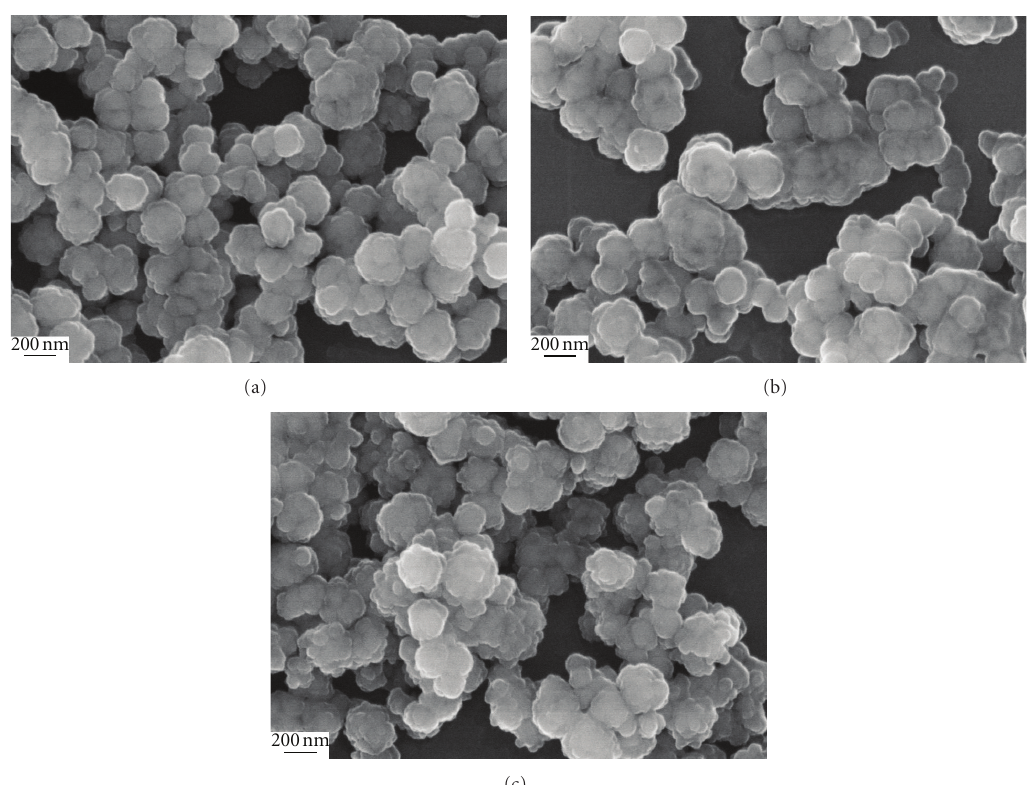
Figure 4: SEM images of (a) Fe 3 O 4 , (b) carbon-coated Fe 3 O 4 microspheres and (c) Sample B.